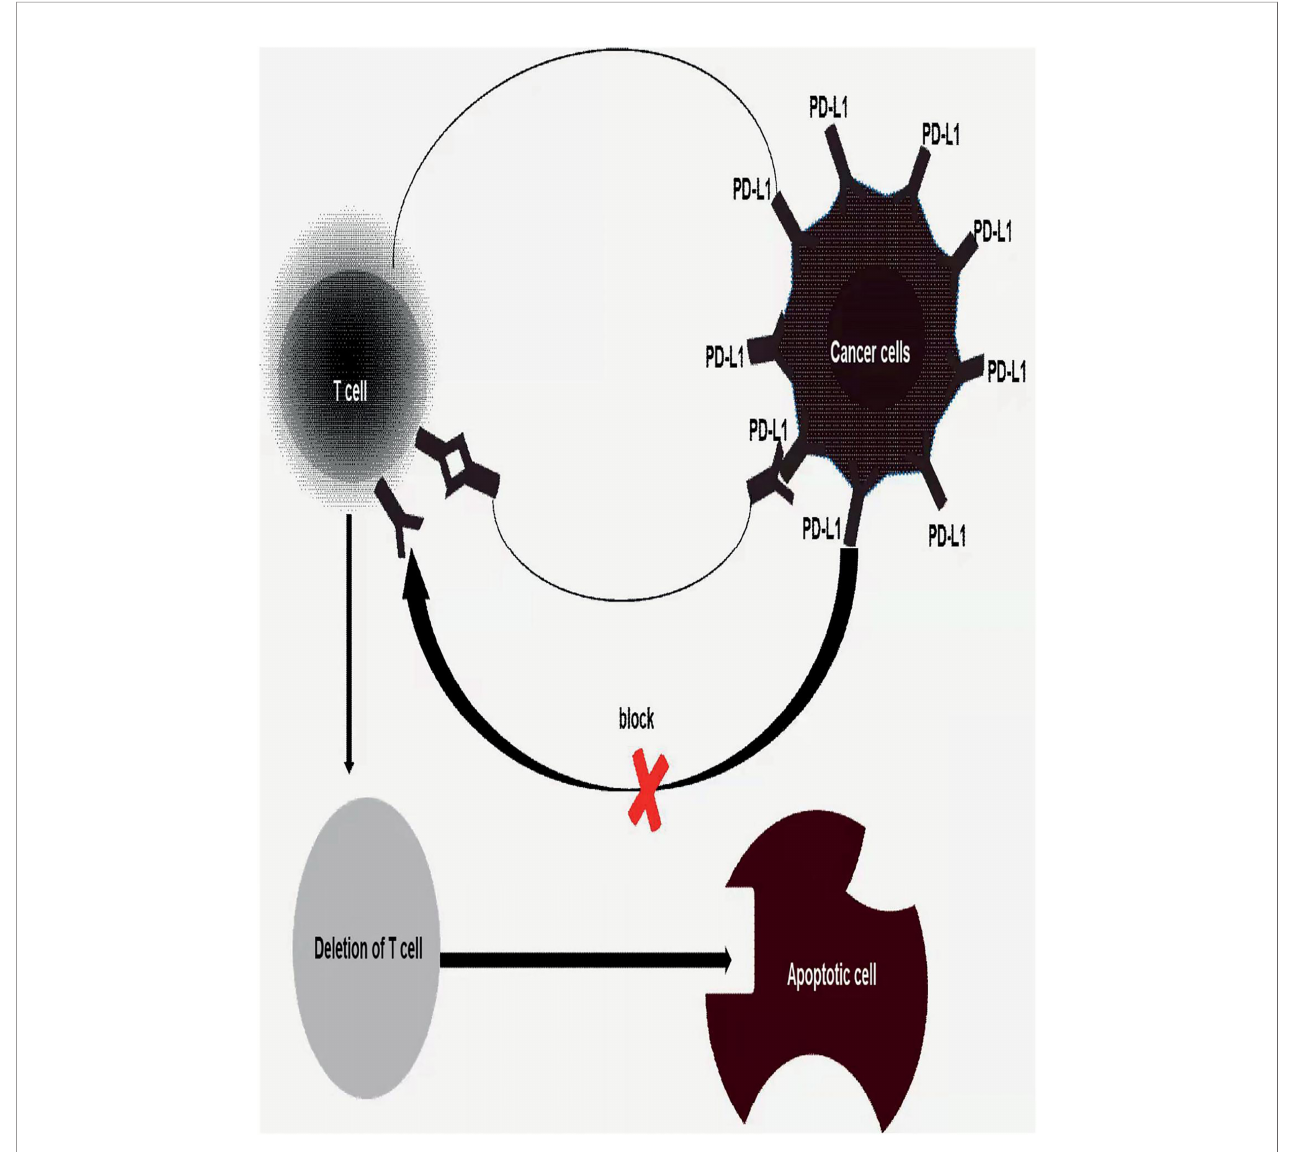
FIGURE 2 | Once tumor ’ s PD-L1 binds to T cells ’ s PD-1 induced depletion, disability and apoptosis of T cells, achieves tumor immune escape. Thus, block the binding of PD1/PD-L1 would be an effective treatment for human cancer or inhibiting tumor proliferation and